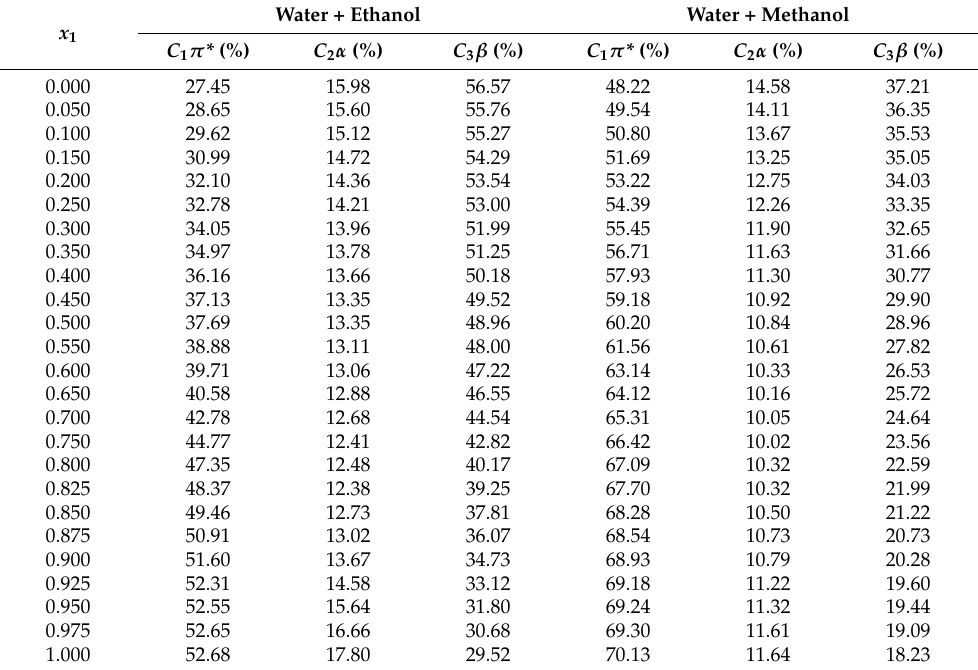
Table 5. Contribution of each type of interaction in solutions of 4-tolyl-1,2,4-triazol-1-ium-4 (cid:48) -nitro- phenacylid (TTNPY) in binary hydroxylic solvents